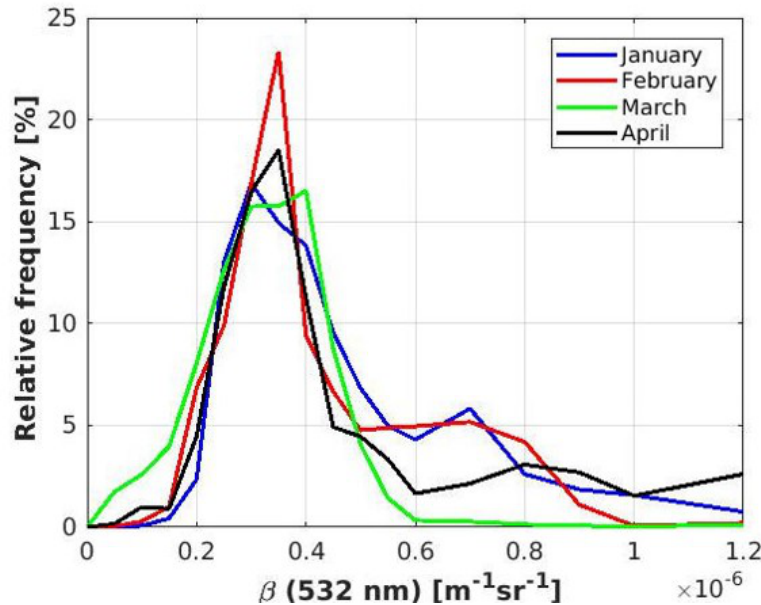
Figure 2. 700–1500 m: Frequency of β 532 .